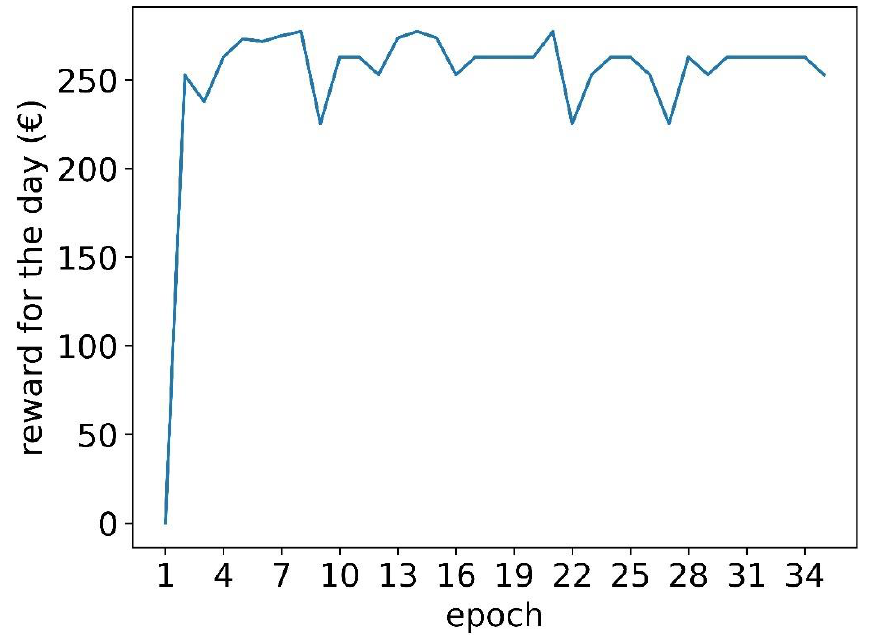
Figure 9. The cumulative reward for all of the hours for one of the validation days (4 September 2020).